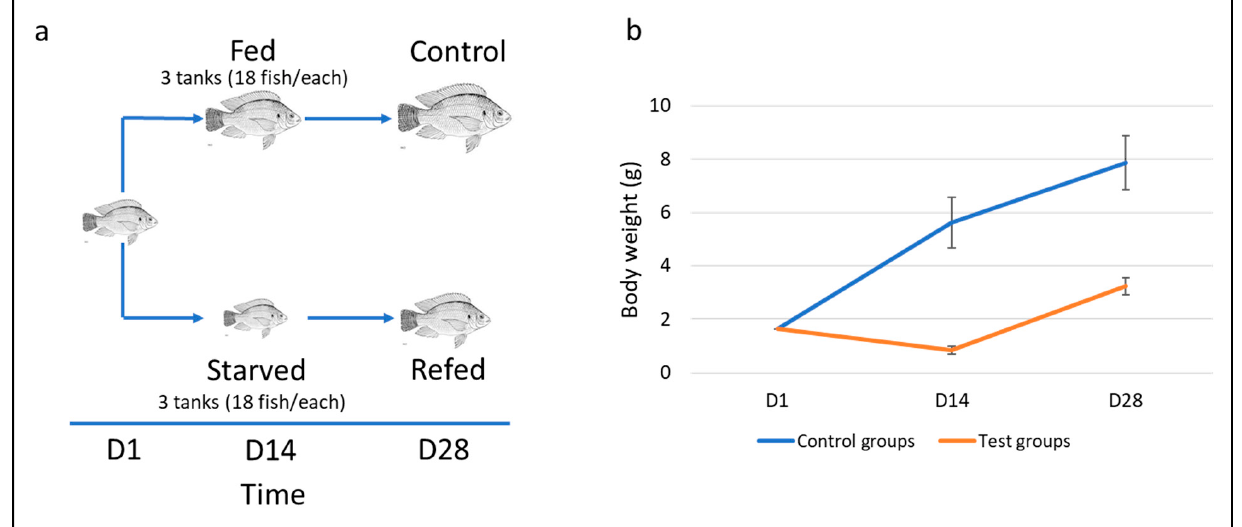
Figure 1. ( a ) Illustration of the experimental design. Fish were subjected to a two-week cycle of fasting-refeeding schedule. ( b ) Changes in tilapia body weight over the time course of the fasting- refeeding experiment. Test groups include the starved group (D14) and refed group (D28), whereas control groups include the fed group (D14) and control group (D28).